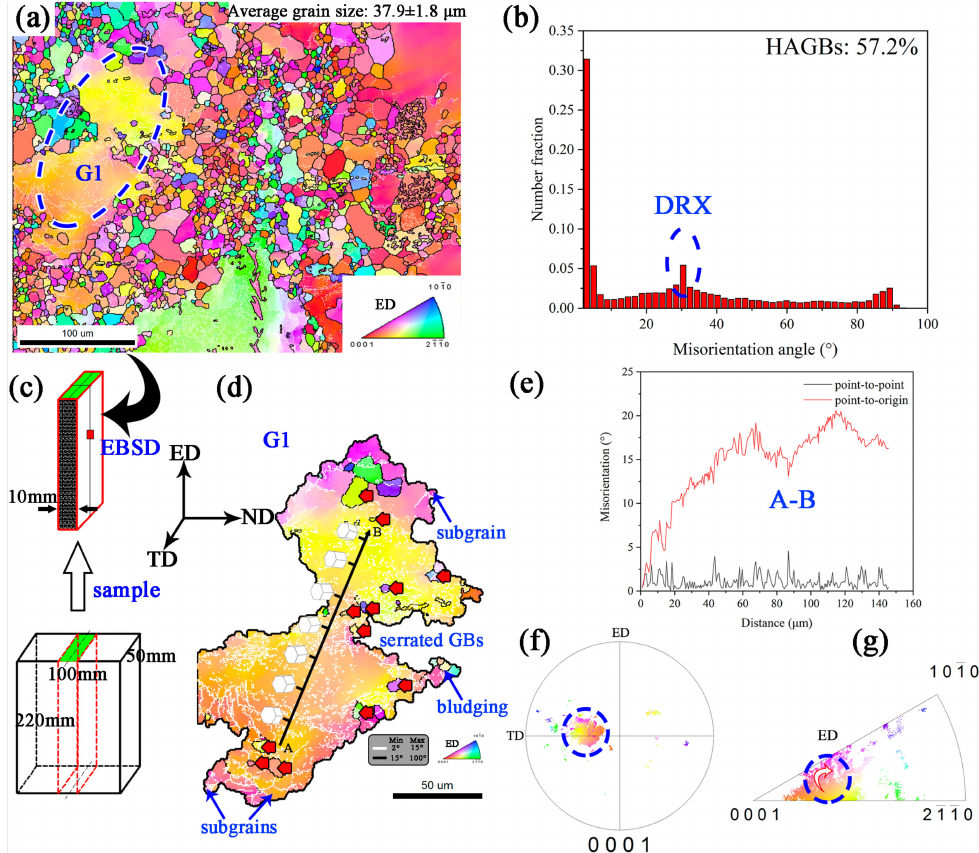
Figure 5. ( a ) Inverse pole figure map of the 1 pass of the CEE-AEC-processed sample, ( b ) misorientation distribution, ( c ) schematic diagram of the location of electron backscatter di ff raction (EBSD) measurement within the sample, ( d ) inverse pole figure map of the coarse grain G1, ( e ) line profile of misorientation angle along AB in ( d ), ( f ) the crystallographic orientations in G1, and ( g ) their corresponding inverse pole